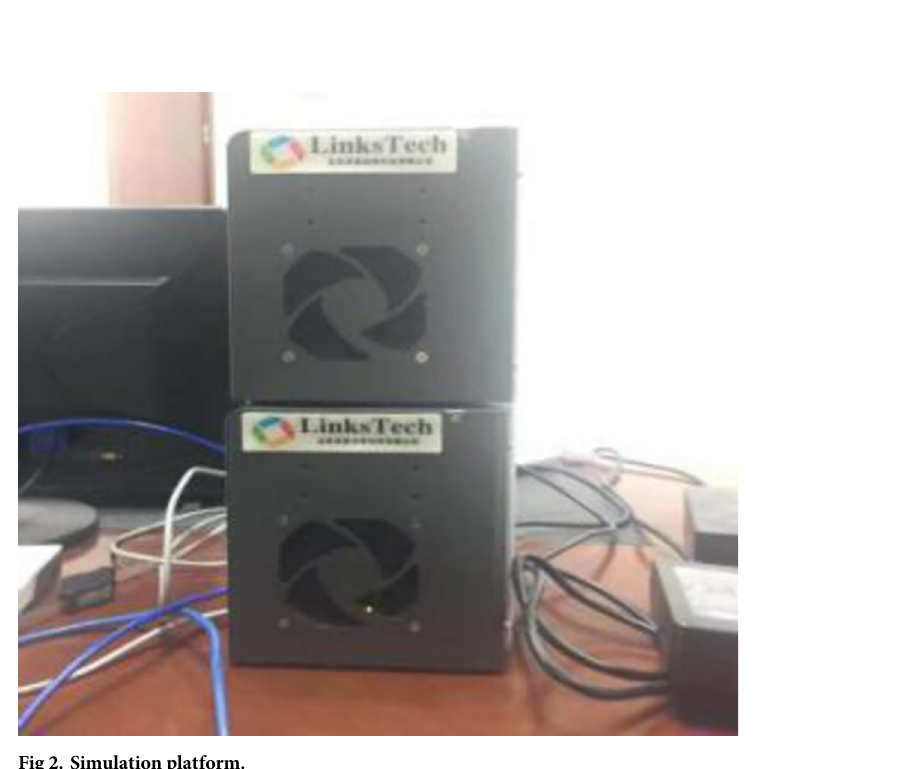
Fig 2. Simulation